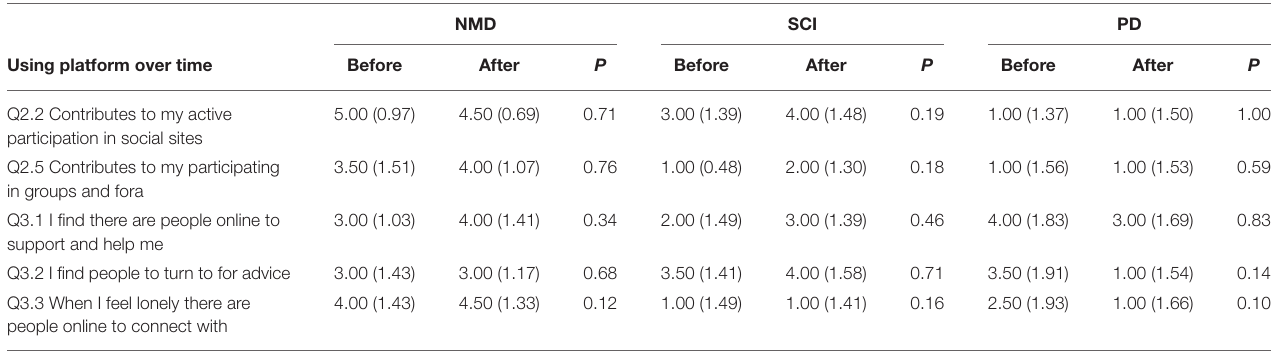
TABLE 5 | Descriptive statistics (median and standard deviation) for “before” and “after” answers on participation social indicator questions (before and after) and comparison using Wilcoxon non-parametric statistical test. NMD SCI PD Using platform over time